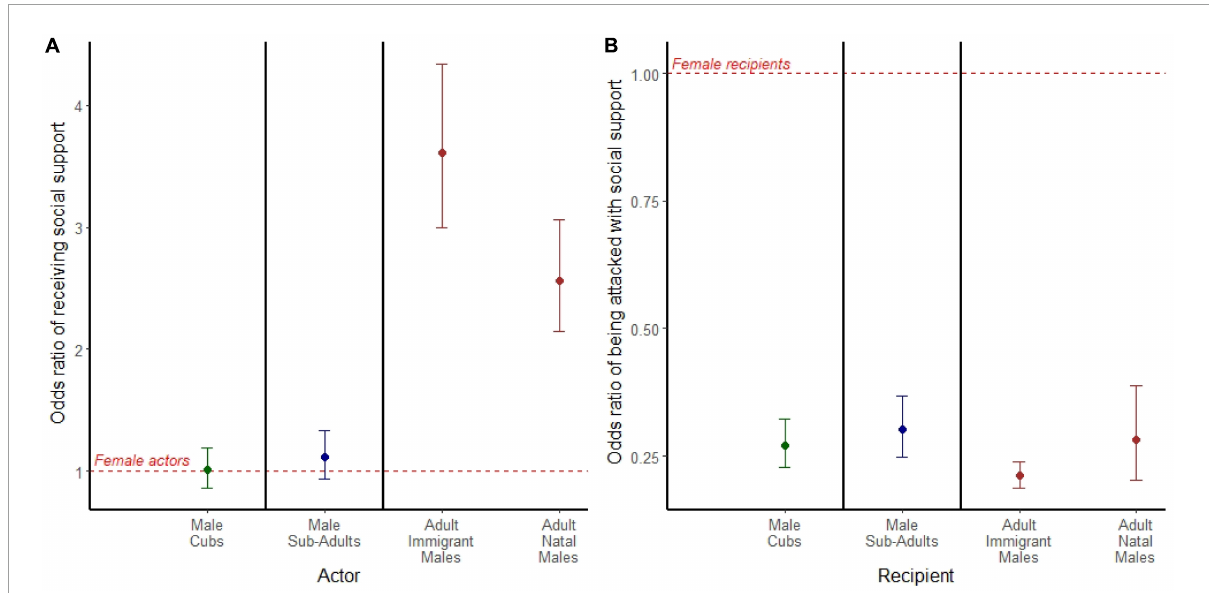
FIGURE4 (A) Odds ratio of the acting aggressor receiving social support in aggression. (B) Odds ratio of an individual being targeted by an actor with social support. (A,B) Models are separated by bold black lines, and age is depicted by color where cubs are green, subadults are blue, and adults are brown. Points represent the odds ratio and error bars represent 95% confidence intervals around the odds ratio. Each point is compared to a female reference group of the same age class represented by the red dashed